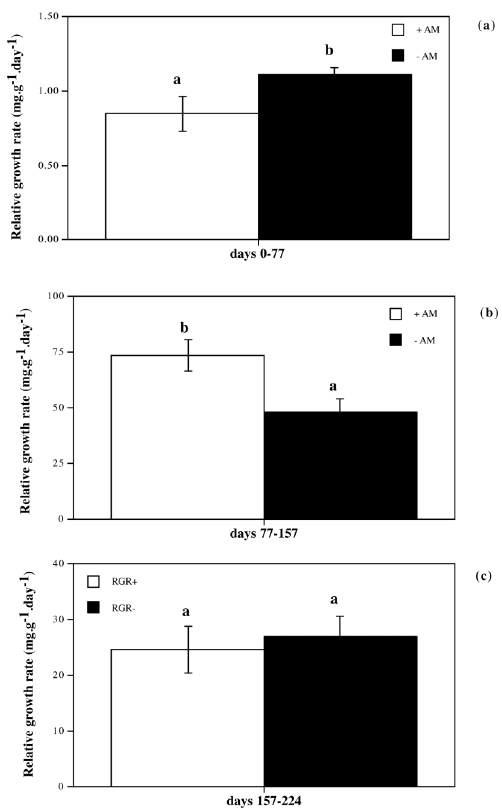
Fig. 2 . Plant biomass (g) of Agathosma betulina for (a) the growth period 0–77 days, (b) the growth period 77–157 days and for (c) the growth period 157–224 days. Differences between arbuscular mycorrhizal inoculated (+AM) and non-AM (–AM) plants were determined by t-test for independent samples by groups. Statisti- cally significant differences (p £ 0.05) between AM inoculated and non-AM plants for each growth period are indicated by dif- ferent letters. Error bars represent mean ± SE (n = 4).